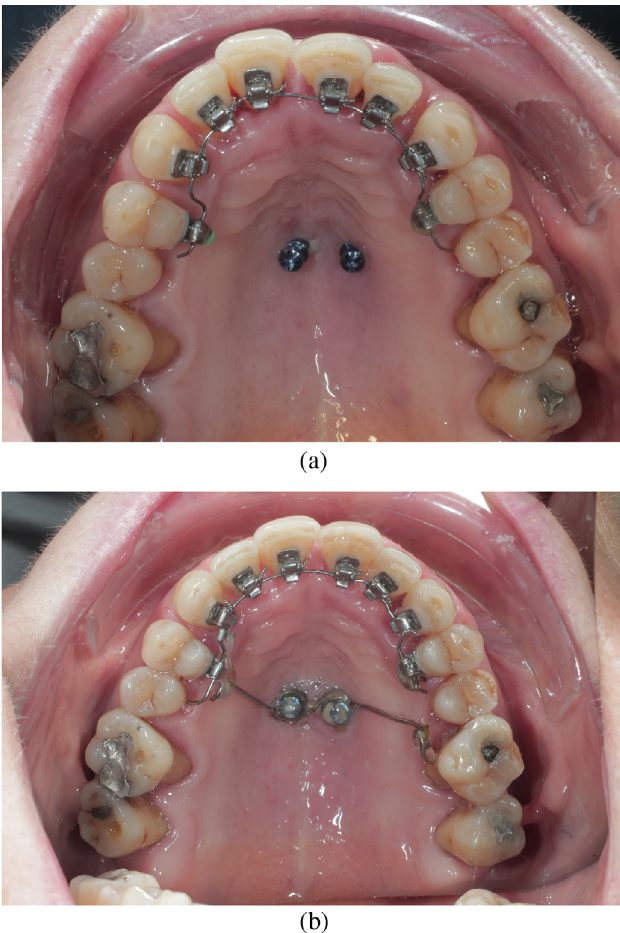
Fig. 2. (a) Miniscrews and Edgewise® system have been installed. (b) 8 months post-orthodontic